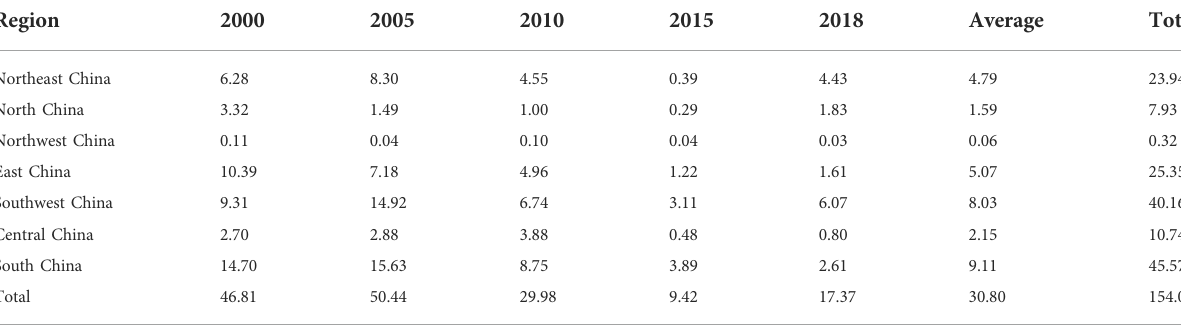
TABLE 3 Burned area in various Chinese regions (unit: 10 4 hm 2 ).